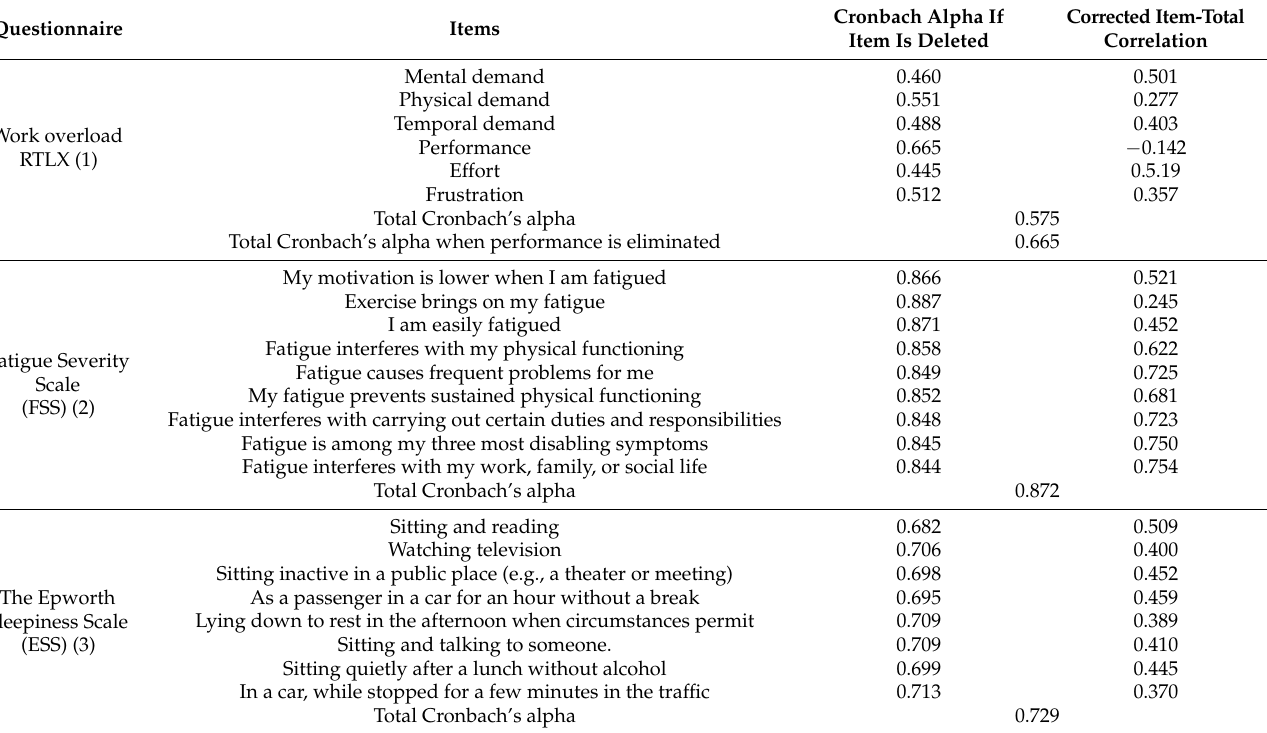
Table 3. Reliability analysis. Cronbach’s alpha if each item is deleted and the item-total correlation across the items of the RTLX, Fatigue Severity Scale, and Epworth Sleepiness Scale